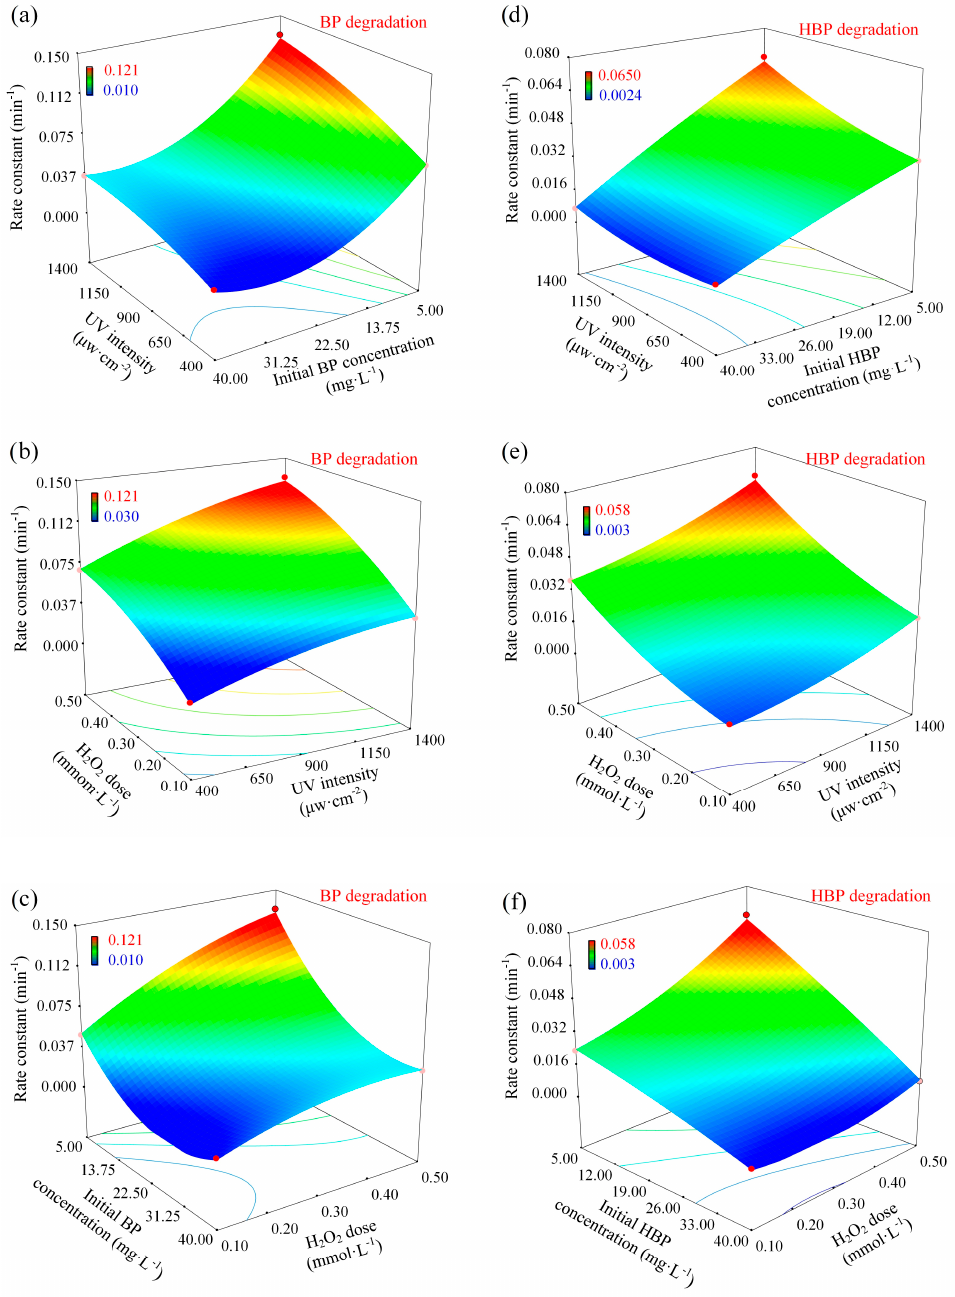
Figure 4. Response surface plots that present the inner effects of three variables on the rate constant ( K ): BP and HBP models. ( a ) Initial BP concentration and UV intensity; ( b ) H 2 O 2 dose and UV intensity; ( c ) initial BP concentration and H 2 O 2 dose; ( d ) initial HBP concentration and UV intensity; ( e ) H 2 O 2 dose and UV intensity; ( f ) initial HBP concentration and H 2 O 2 dose. (Colors represent the strength of rate constant from the low (blue) to the medium (green) and to the large (red)).